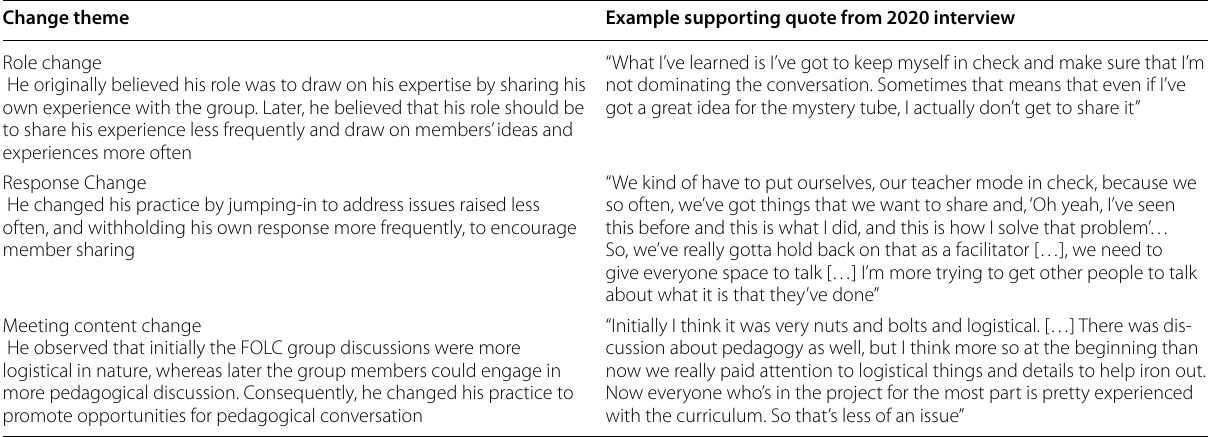
Full interview transcript and additional supporting quotes for the change themes can be found in Additional file 5, Additional file 6: Table S1